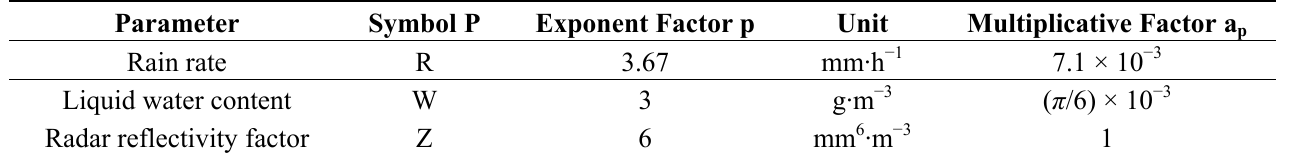
(cid:2998) (cid:1516) (cid:1830) (cid:3043) (cid:1840)((cid:1830))(cid:1856)(cid:1830) (cid:3043) (cid:2868)